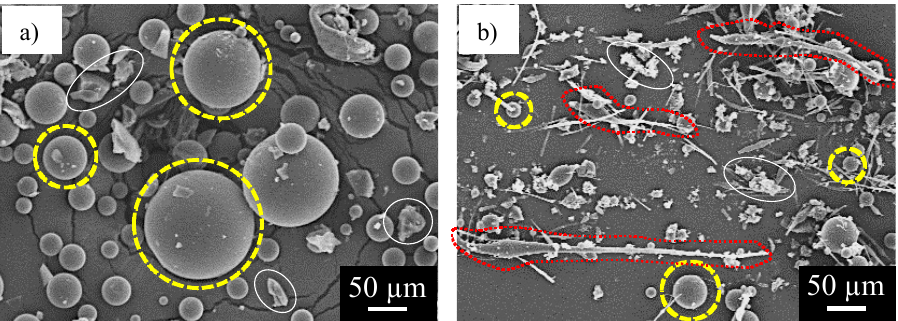
Figure 5. SEM image of the capsules synthesized from the prepolymer solution with IPDI and xylene: ( a ) without heating and ( b ) with heating.